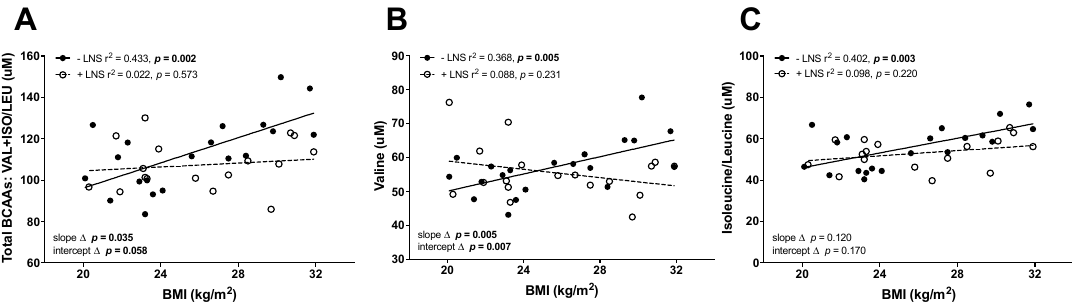
Figure 2. Comparative regression analysis was used to assess associations between branched chain amino acid concentrations and maternal pre-pregnancy BMI for ( A ) total branched amino acids, ( B ) valine, and ( C ) isoleucine and leucine in mothers who consumed LNS ( n = 19 mothers) or no consumption of LNS ( n = 20 mothers) at 12 weeks gestation. Significance was set at p ≤ 0.05.